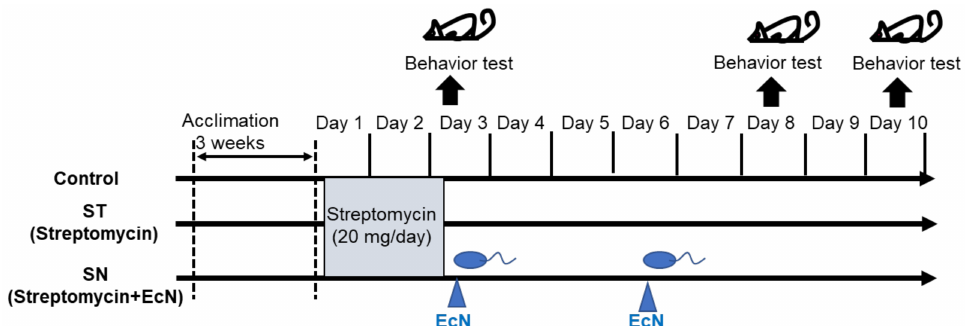
Figure 1. Schematic diagram of the experimental study design. Male C57BL/6 mice were divided into three groups ( n = 7 per group): control, ST (Streptomycin-treated group), and SN (Streptomycin and EcN-treated group). On day 1, streptomycin (20 mg/day) was administered to the mice from both ST and SN groups. Only the mice in the SN group were administered EcN (1 × CFU) via oral gavage on days 3 and 6. Behavior tests were conducted on days 3, 8, and 10. Day 3 behavior tests were performed before EcN treatment. Body weight was also measured on days 3 and 10 (EcN: Escherichia coli strain Nissle 1917; CFU: colony-forming